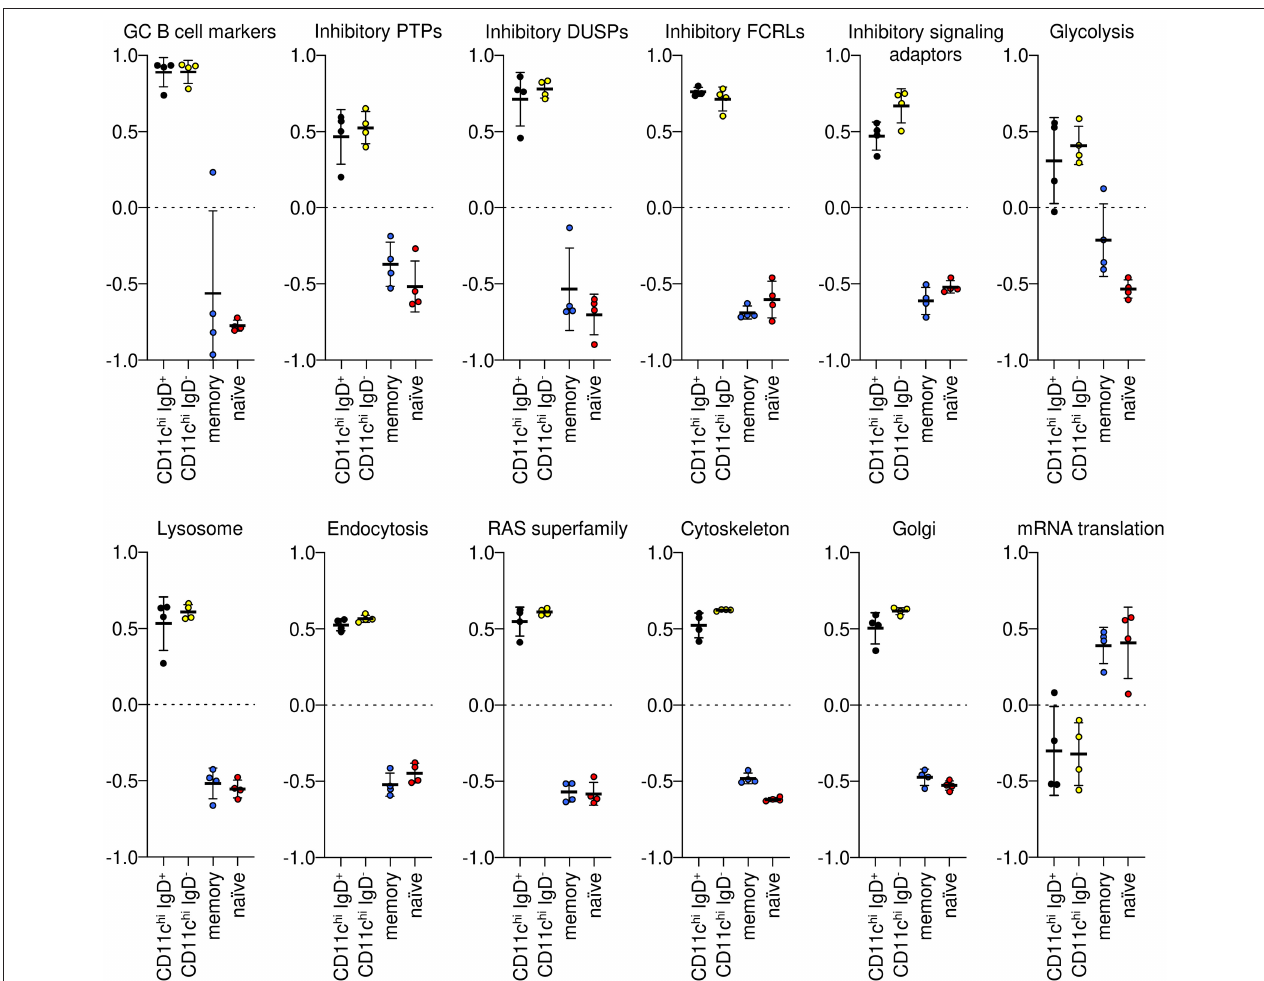
FIGURE 2 | GSVA of gene signatures enriched in CD11c hi B cells by GO BP and BIG-C analysis. IgD + and IgD − B cells were not significantly different from each other, but they were significantly different (Tukey’s multiple comparisons test p < 0.0001) from memory and naïve B cells for each signature. Gene symbols for each GSVA enrichment module are in Supplementary Data File 1